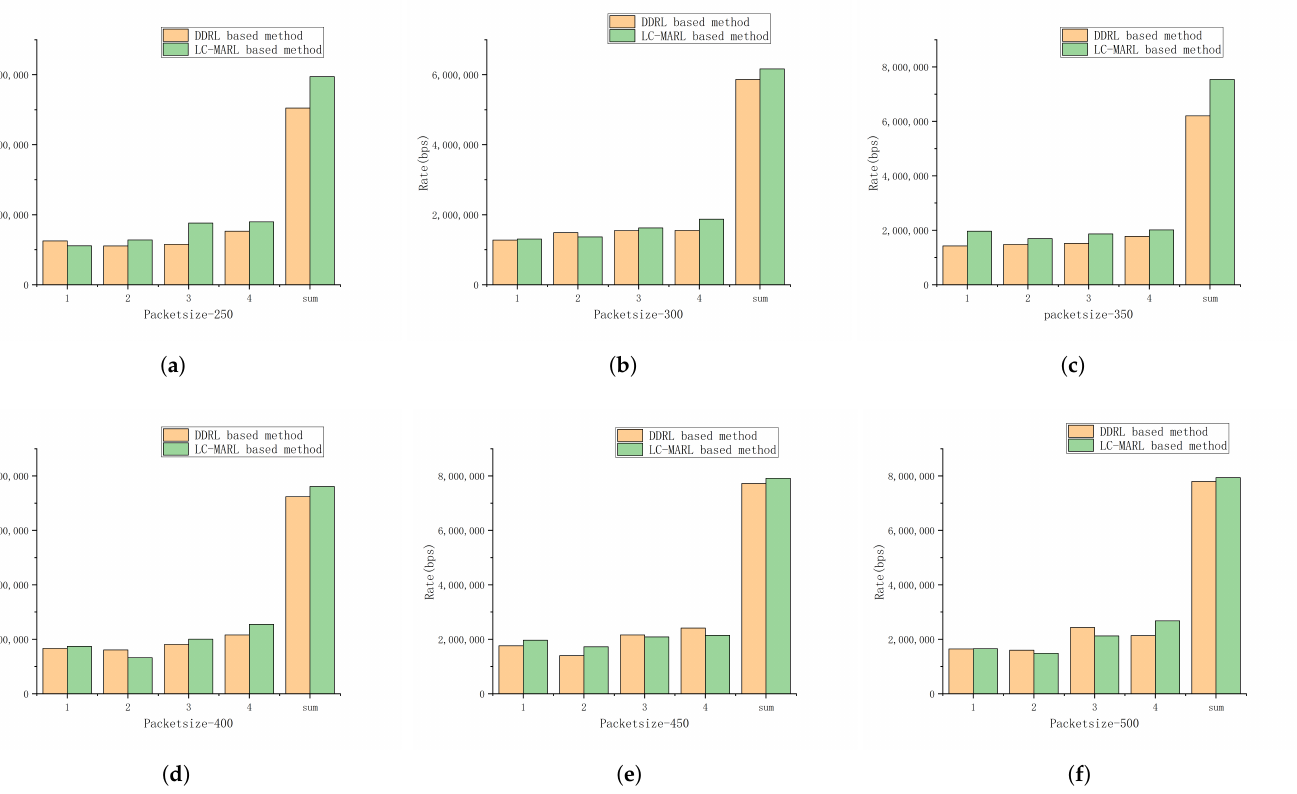
Figure 8. BS rate and overall rate comparison in different packet size.( a ) packet size-250; ( b ) packet size-300; ( c ) packet size-350; ( d ) packet size-400; ( e ) packet size-450; ( f ) packet